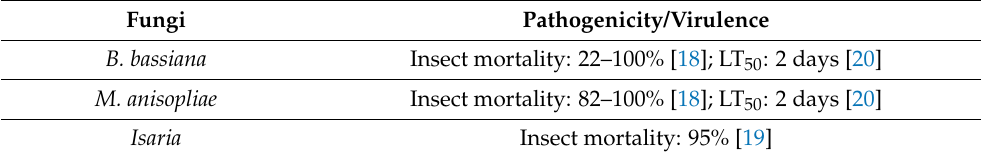
Table 2. Previous results on the action of B. bassiana , M. anisopliae , and Isaria against T. molitor.